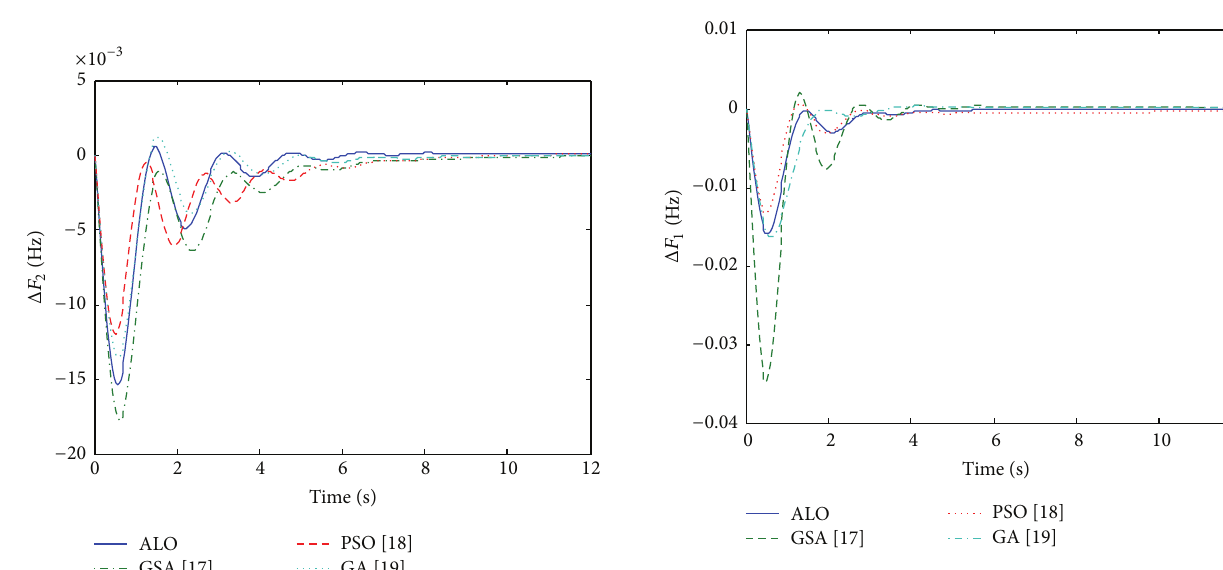
Figure 7: Change in frequency of area 1 by 20% load increase in area